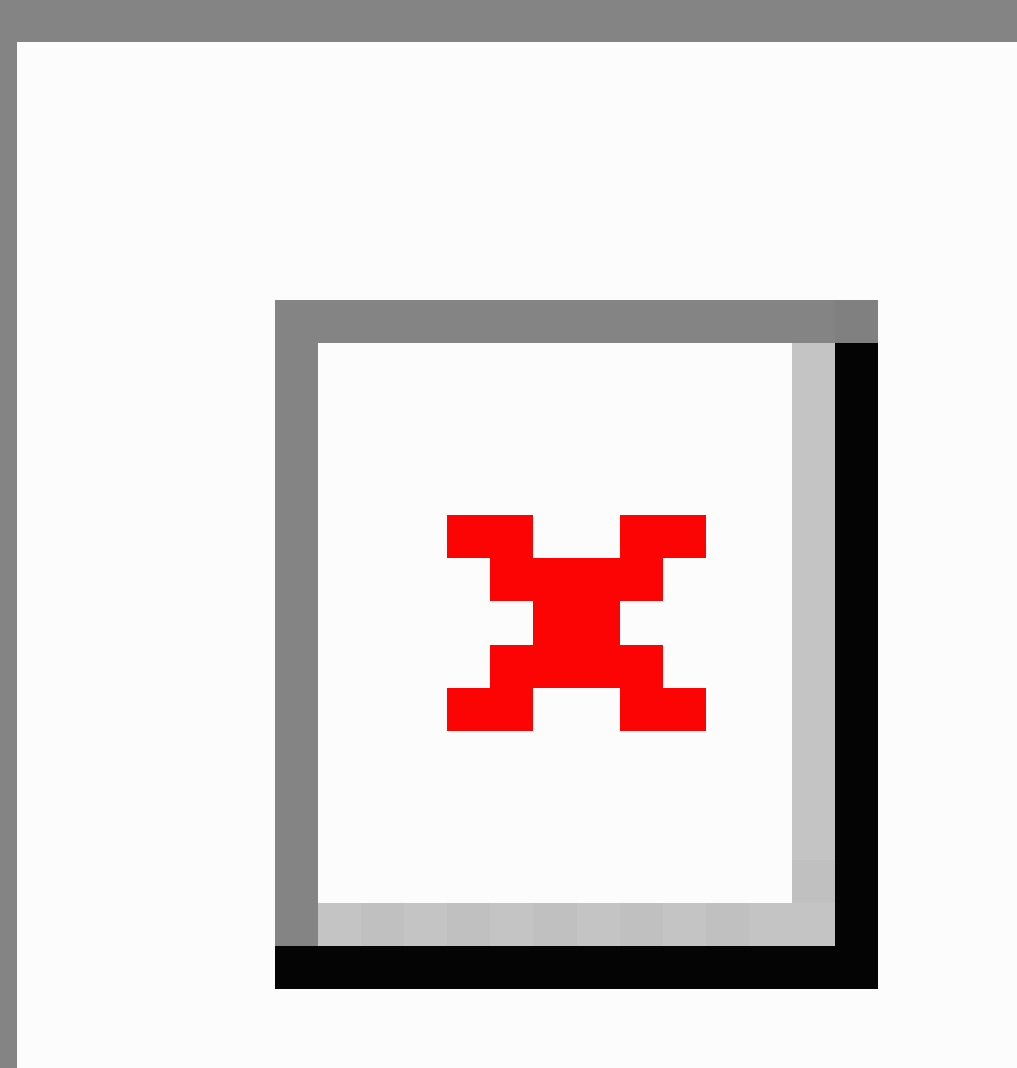
Figure 3. Forest plot for the effect of Internet-based intervention on waist circumference changes. % Weight: weights assigned to